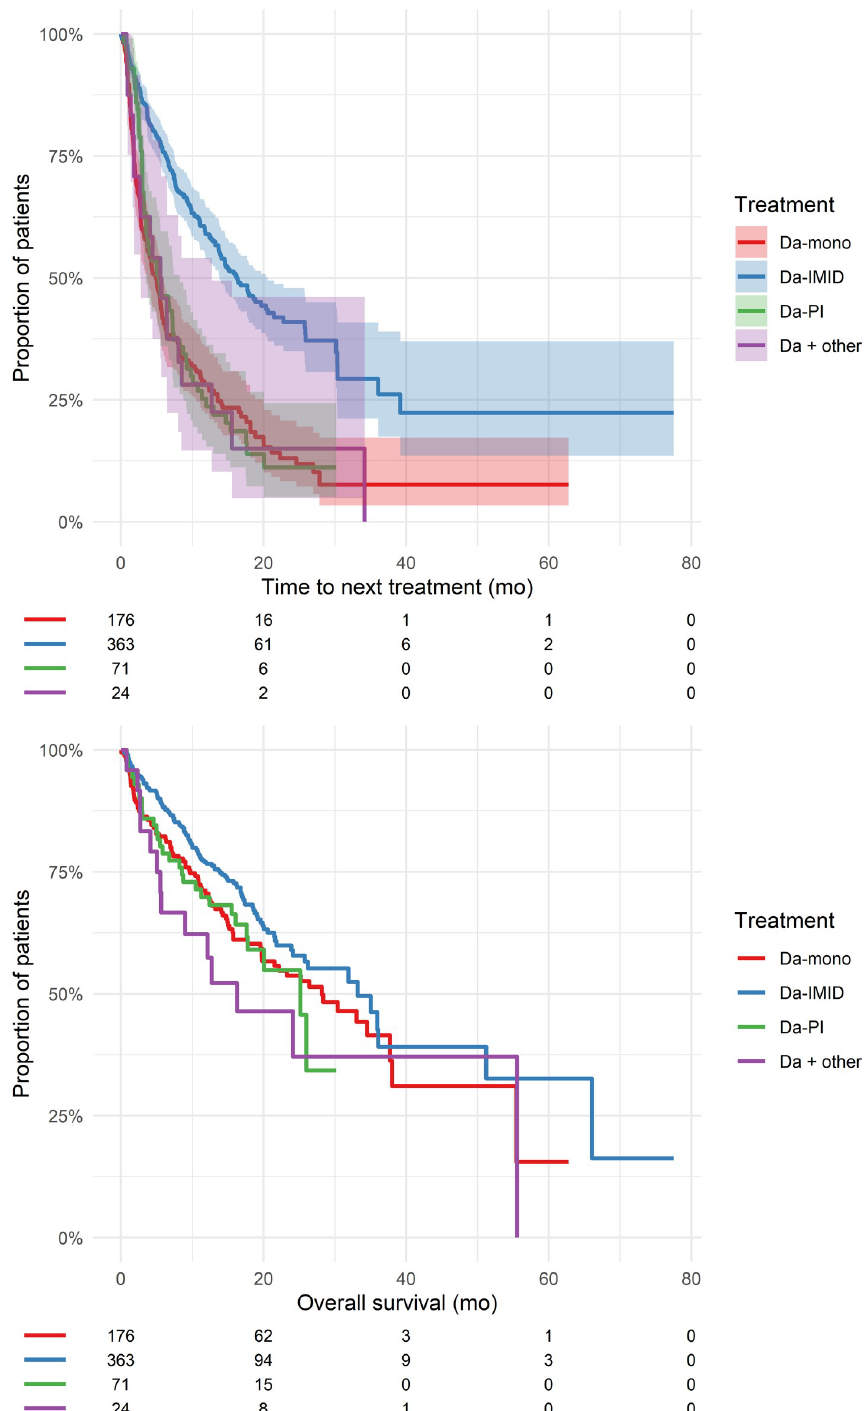
Fig 1. Time to next treatment and overall survival of the first daratumumab therapy. Patients at risk is shown below the figure. Abbreviations: Da-other = daratumumab in other combinations than IMiD and PI; mo = months.